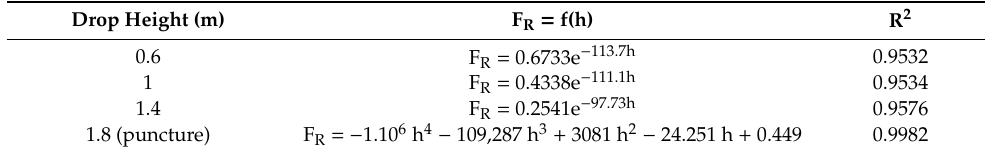
Table 2. Correlation between the impact force F R and the height h for the drop hammer weight of 80 kg.